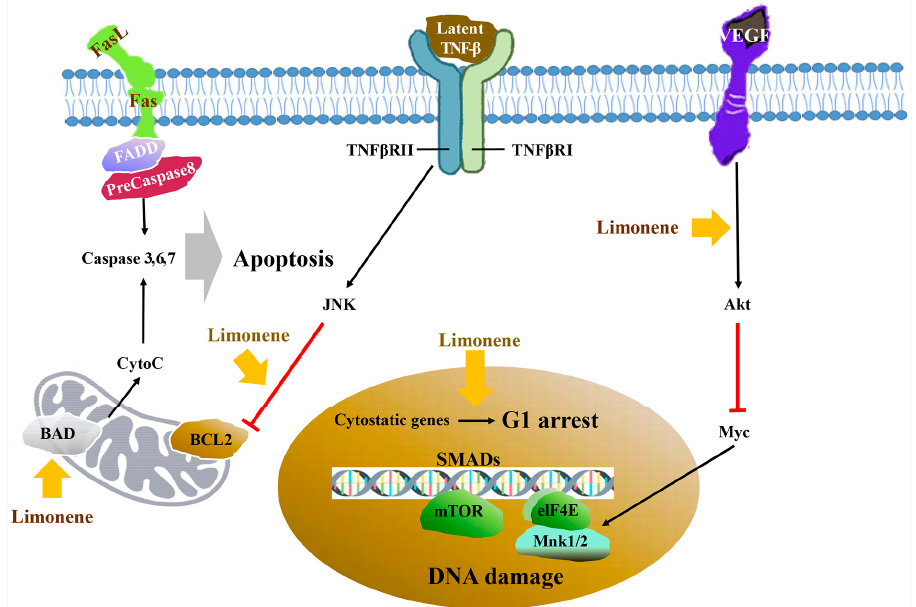
Figure 6. Anti-proliferation mechanism of limonene against cancer cells (modified from Shojaei et Figure 4. 1,8-cineol downregulates LPS-induced inflammation by blocking both NF- κ B transloca- tion and JNK pathway activation (Modified from Greiner et al. 2013 [68]). 1,8-cineol prevents the separation of I κ B and NF- κ Bp65/p55 and then blocks NF- κ B translocation from the cytoplasm to the nucleus, thus acting as a transcription factor for the expression of inflammation-related cytokines such as TNF- α and